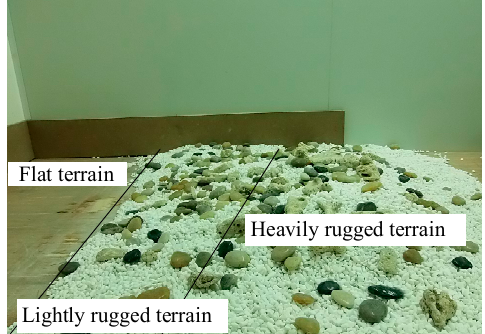
Figure 18. Staged unstructured terrain.